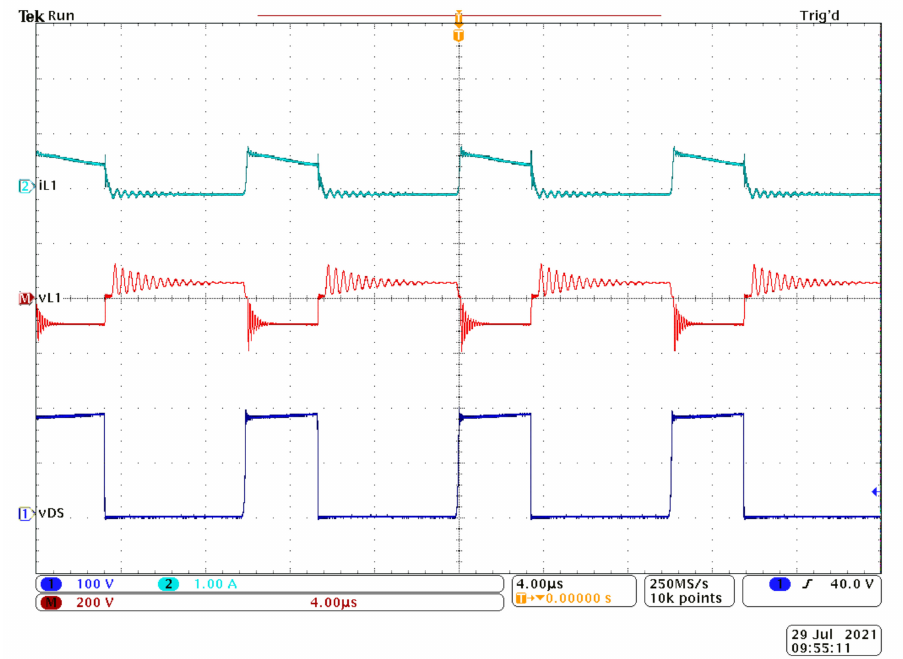
Figure 20. Oscilloscope waveforms: drain to source voltage (dark blue— v DS ); voltage across L 1 (red— v L 1 ); current through L 1 (cyan— i L 1